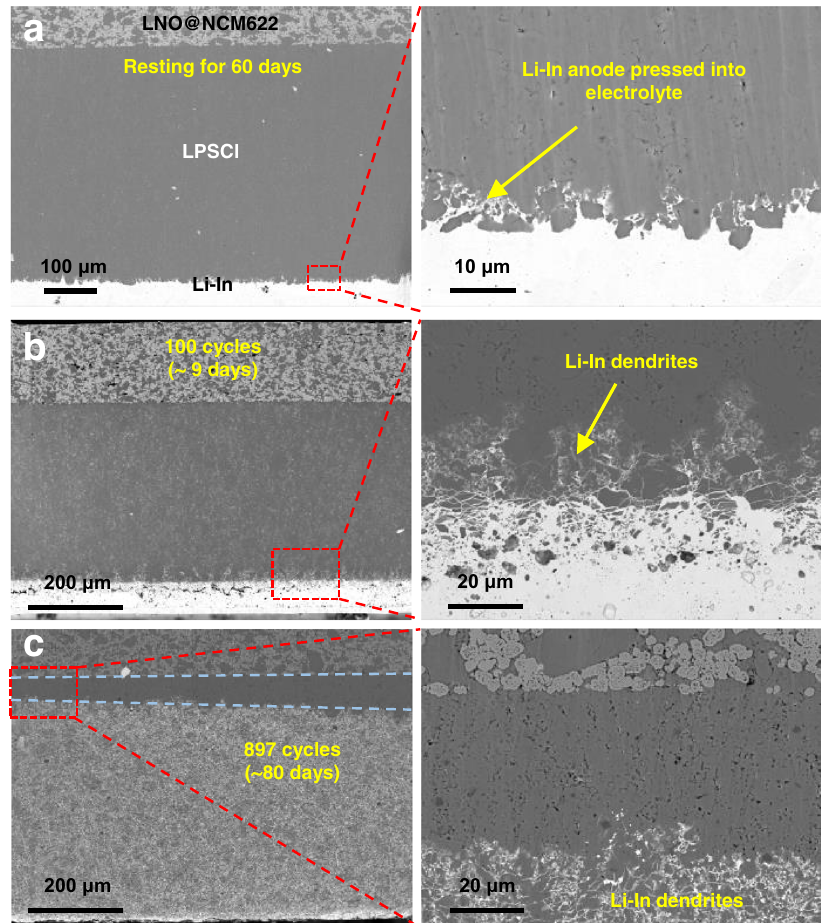
Fig. 2 Cross-sectional SEM images of Li-In|LPSCl|LNO@NCM622 cells with different cycling numbers. a The cell after resting for 60 days without cycling. b The cell after 100 cycles. c The cell after 897 cycles. The cells in ( b ) and ( c ) were cycled at 3.8 mA cm − 2 under a pressure of 150 MPa within the potential range of 2.1 – 3.68